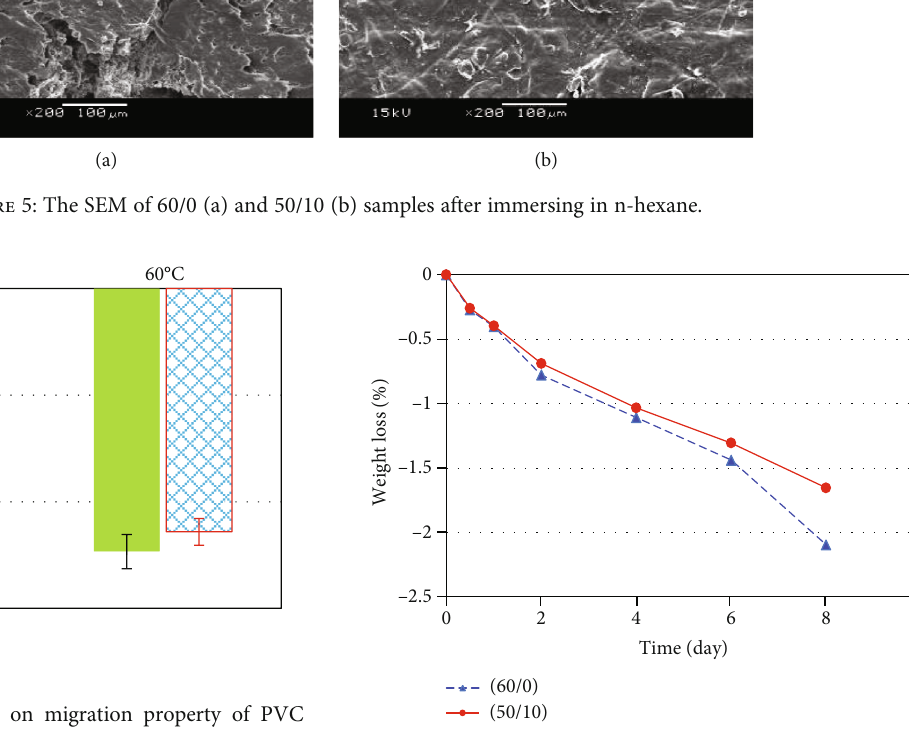
Figure 7: The e ff ect of EeRSO on migration and volatilization of